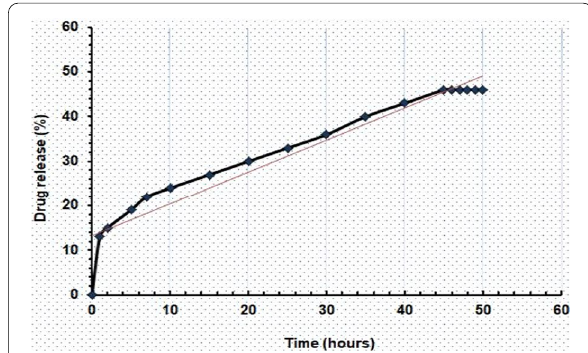
Fig. 6 Amphotericin B release pattern from chitosan nanoparticles (chitosan 3 mg/mL, TPP 2 mg/mL, pH of the medium 7.4)